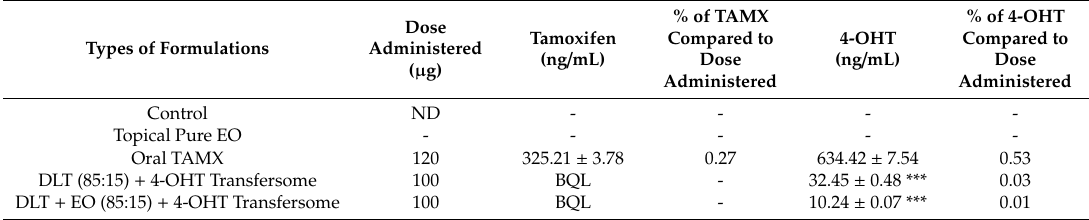
Table 3. Plasma levels of TAMX and 4-OHT in BALB / c mice when comparing the two di ff erent routes of administration.